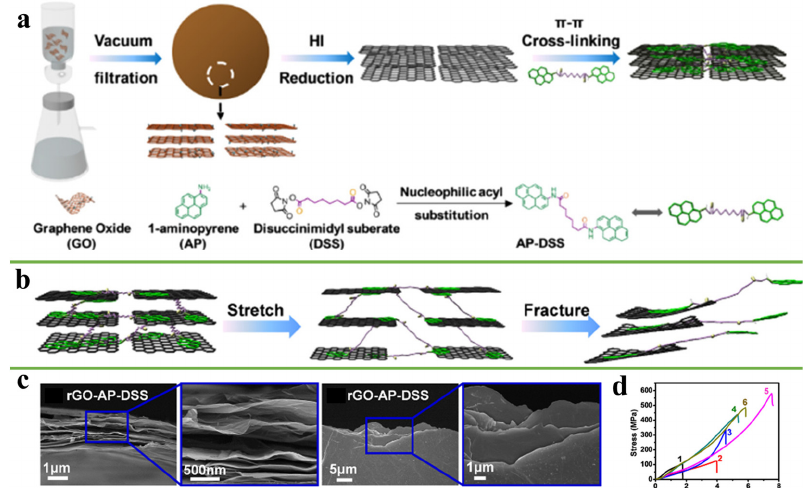
Figure 6. ( a ) Schematic illustration of the fabrication of bioinspired rGO-AP-DSS films. ( b ) Proposed fracture mechanism of rGO-AP-DSS film. ( c ) SEM images of the front- and side-view fracture surfaces of rGO-AP-DSS films after tensile testing. ( d ) Stress-strain curves of GO (curve 1), rGO (curve 2), and rGO-AP-DSS with different contents of AP-DSS designated as rGOAP-DSS-I (curve 3), rGO-AP-DSS-II (curve 4), rGO-AP-DSS-III (curve 5), and rGO-AP-DSS-IV (curve 6). Reprinted with permission from ref. [67] Copyright 2017, American Chemical